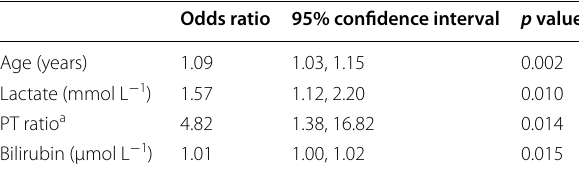
Table 2 Factors predictive of mortality at 12 months